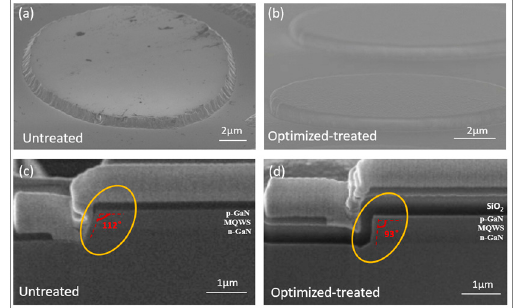
Figure 3. ( a ) SEM images of untreated sample S1; ( b ) SEM image of the optimized-treated sample S5; ( c ) cross-sectional SEM image of sample S1; ( d ) cross-sectional SEM image of sample S5.